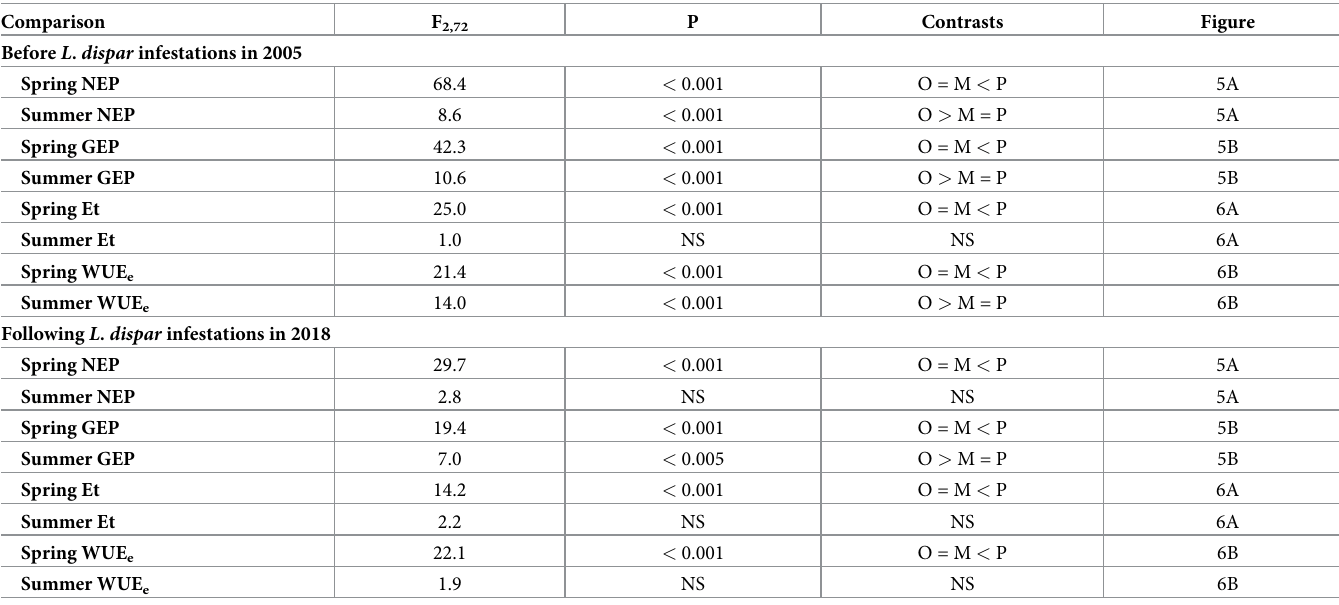
Table 4. Results of ANOVA analyses for ecosystem functioning of the oak, mixed and pine stands.